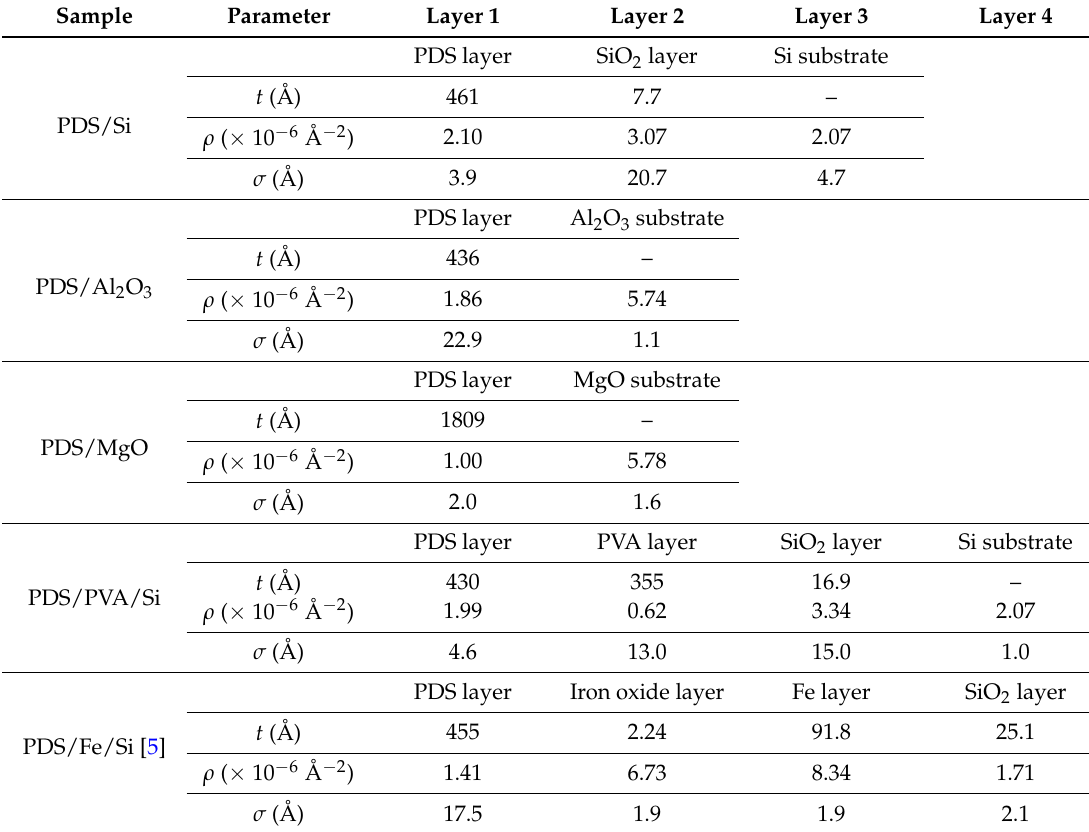
Table 1. Best-fit parameters for the reflectivity model data shown in Figure 3 and reference